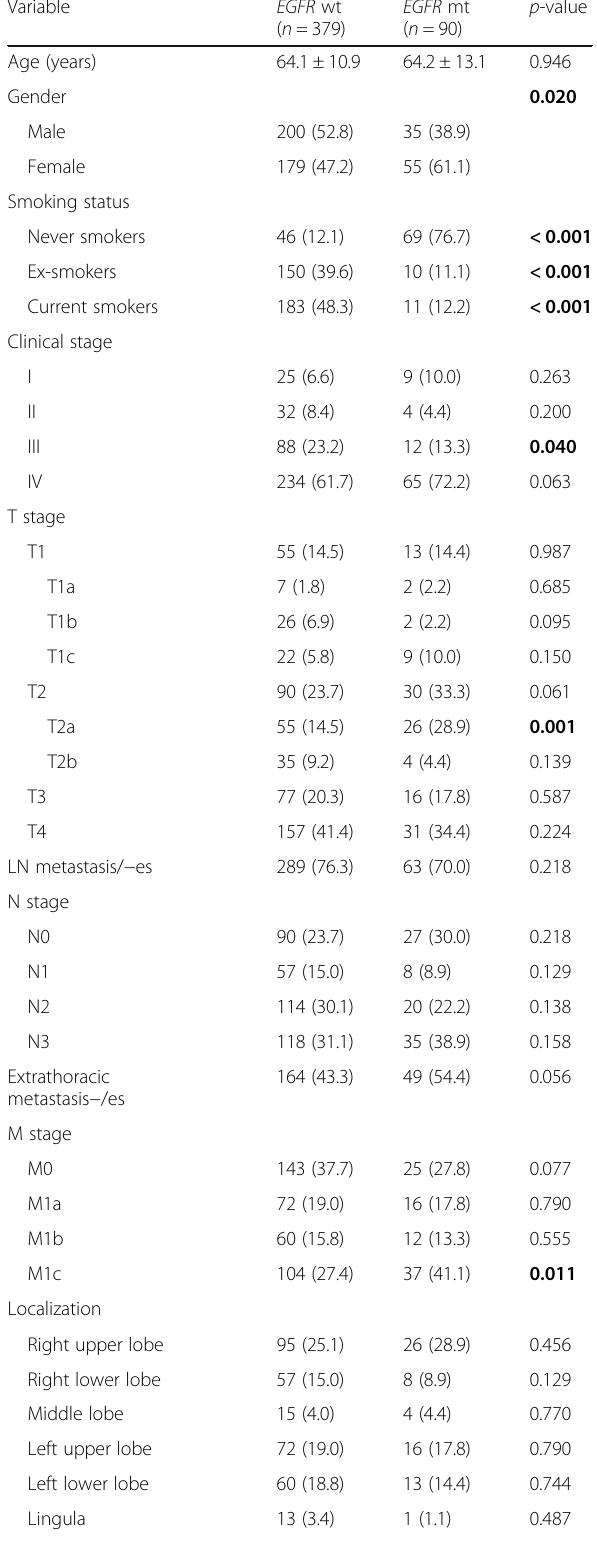
Table 3 Associations between clinicopathological features and EGFR mutational status